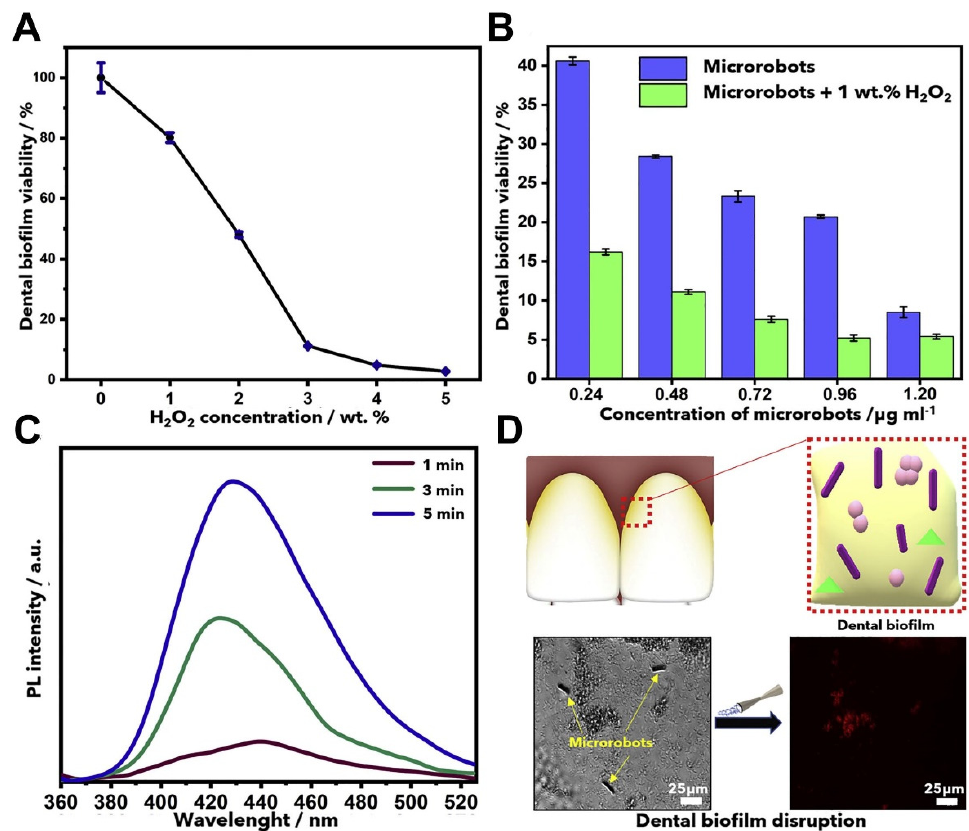
Figure 3. Results of biofilm degradation by TiO 2 /Pt microrobots. ( A ) Dental biofilm viability in the presence of various H 2 O 2 concentrations ( n = 8; error bars reflect standard error of the mean). ( B ) Dental biofilm viability % against concentrations of microrobots ( n = 4; error bars represent the standard error of the mean). ( C ) Fluorescence intensity of 2 − hydroxytherepthalic acid. ( D ) Schematic illustration of dental biofilm disruption by bubble-propelled microrobots over time. Reprinted from Ref. [63] from an open-access journal of Elsevier Publishing.